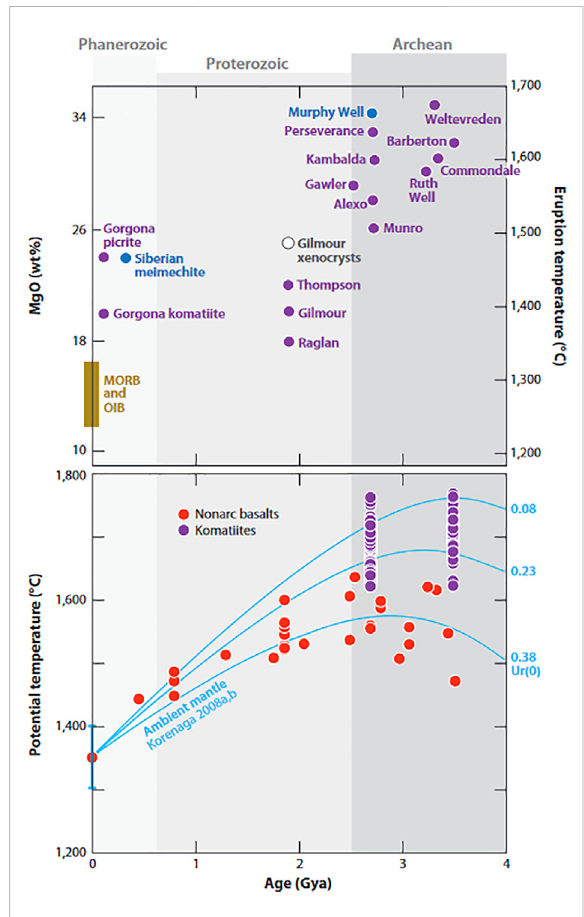
FIGURE 2 Eruption temperaturesand mantle temperaturesof komatiite lavas and melts through time highlighting the higher mantle temperatures during the Archaean and Hadean (after Arndt and Nisbet,